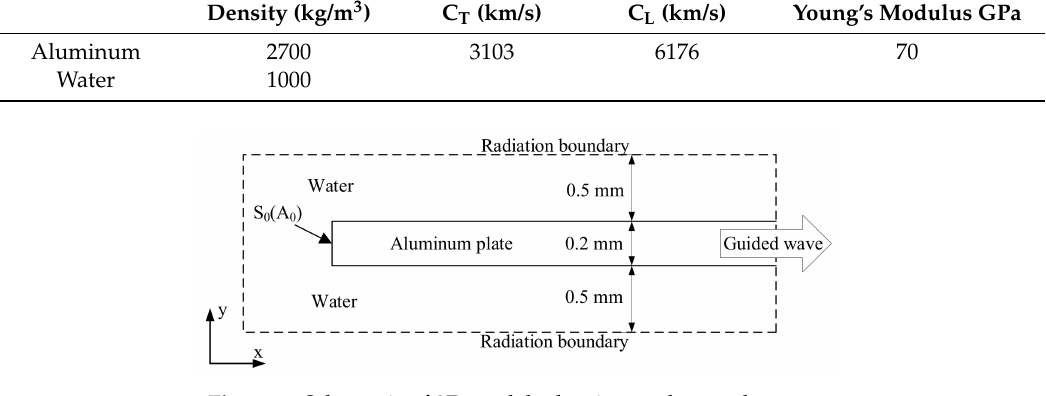
Figure 3. Schematic of 2D model: aluminum plate